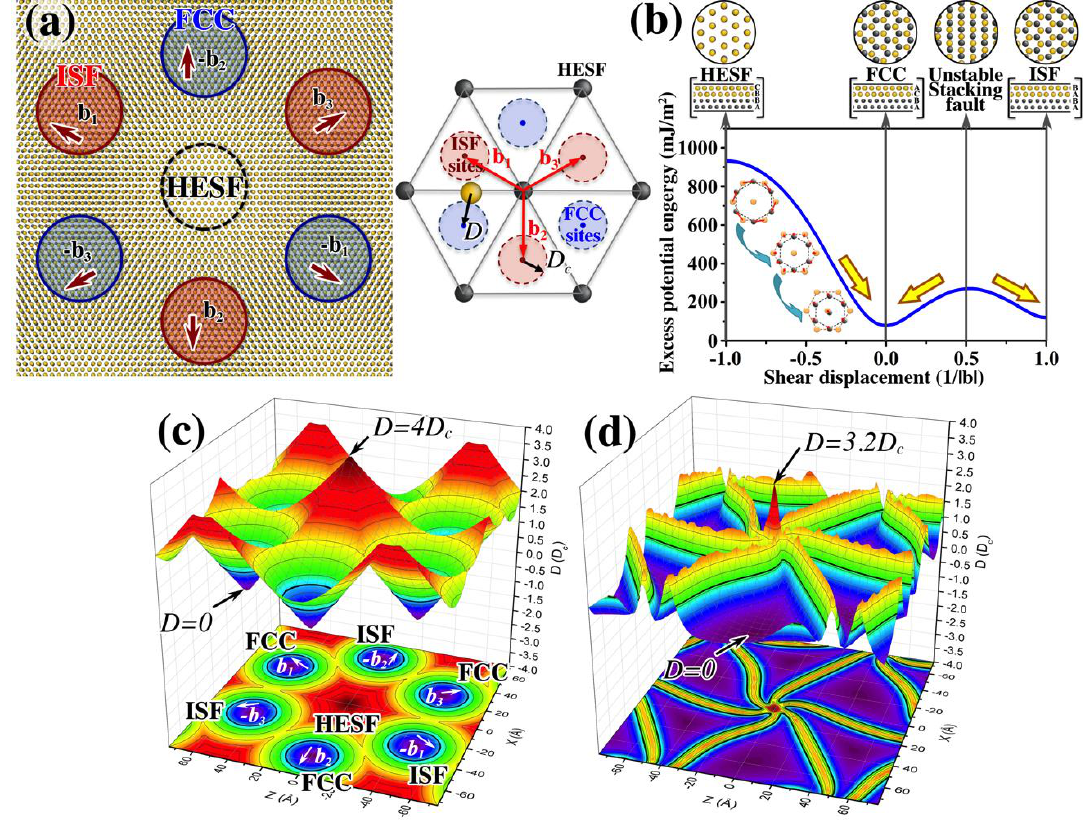
Figure 1. The relaxation of chemical potential energy in the (111) semi-coherent interface. Demonstrated using the Cu–Ni system. ( a ) Shows the various local atomic structures of an un-relaxed interface ( left ) as well as the geometry analysis scheme for the interface ( right ); ( b ) shows the generalized stacking fault energy profile corresponding to various local atomic structures at the interface; ( c , d ) show the contour surface plot according to the geometry analysis of the interface, before and after the relaxation,